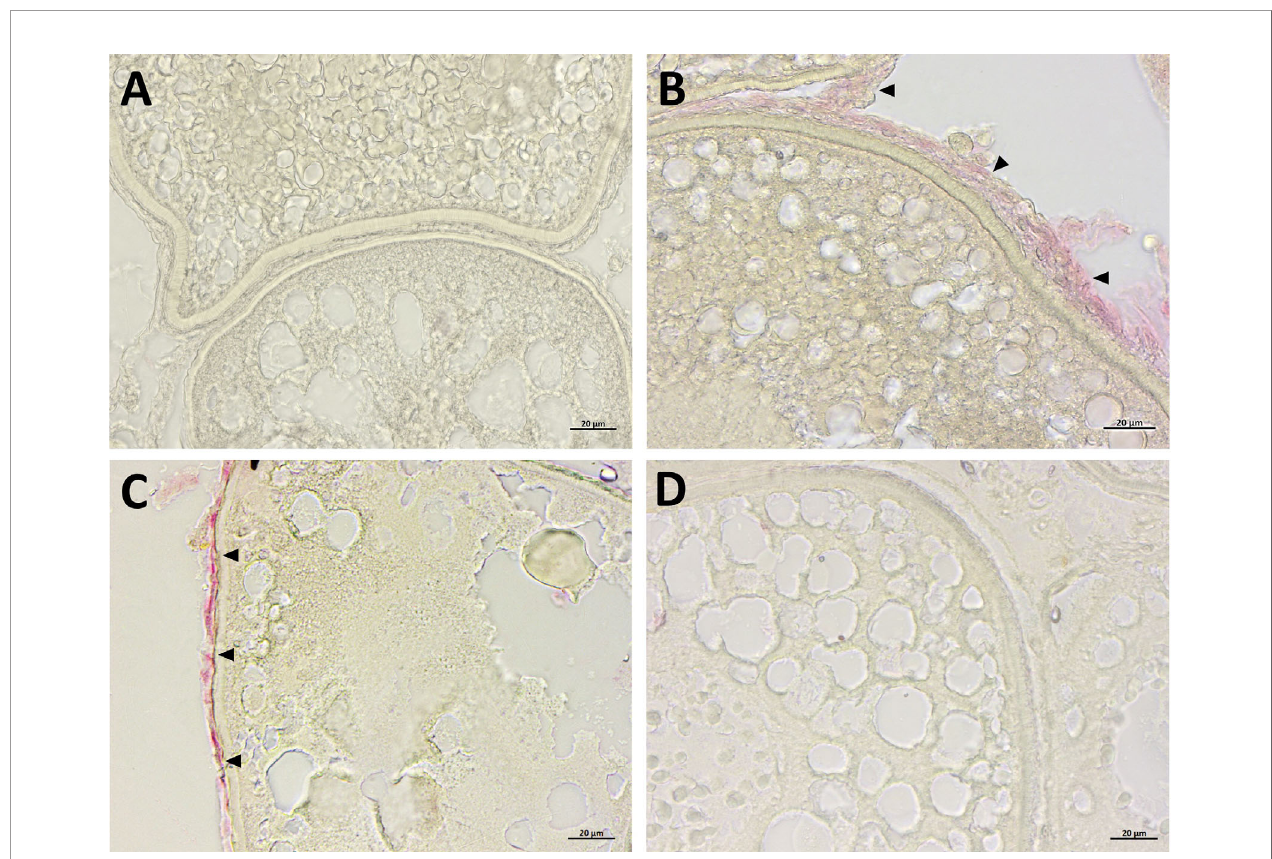
FIGURE 2 | TUNEL assay in ovaries sections from zebra fi sh exposed to DiNP for 21 days. Positive TUNEL reaction stained in red (arrowheads). CTL (A) ; 0.42 m g L − 1 DiNP (B) ; 4.2 m g L − 1 DiNP (C) ; 42 m g L − 1 DiNP (D) . Scale bar: 20 m